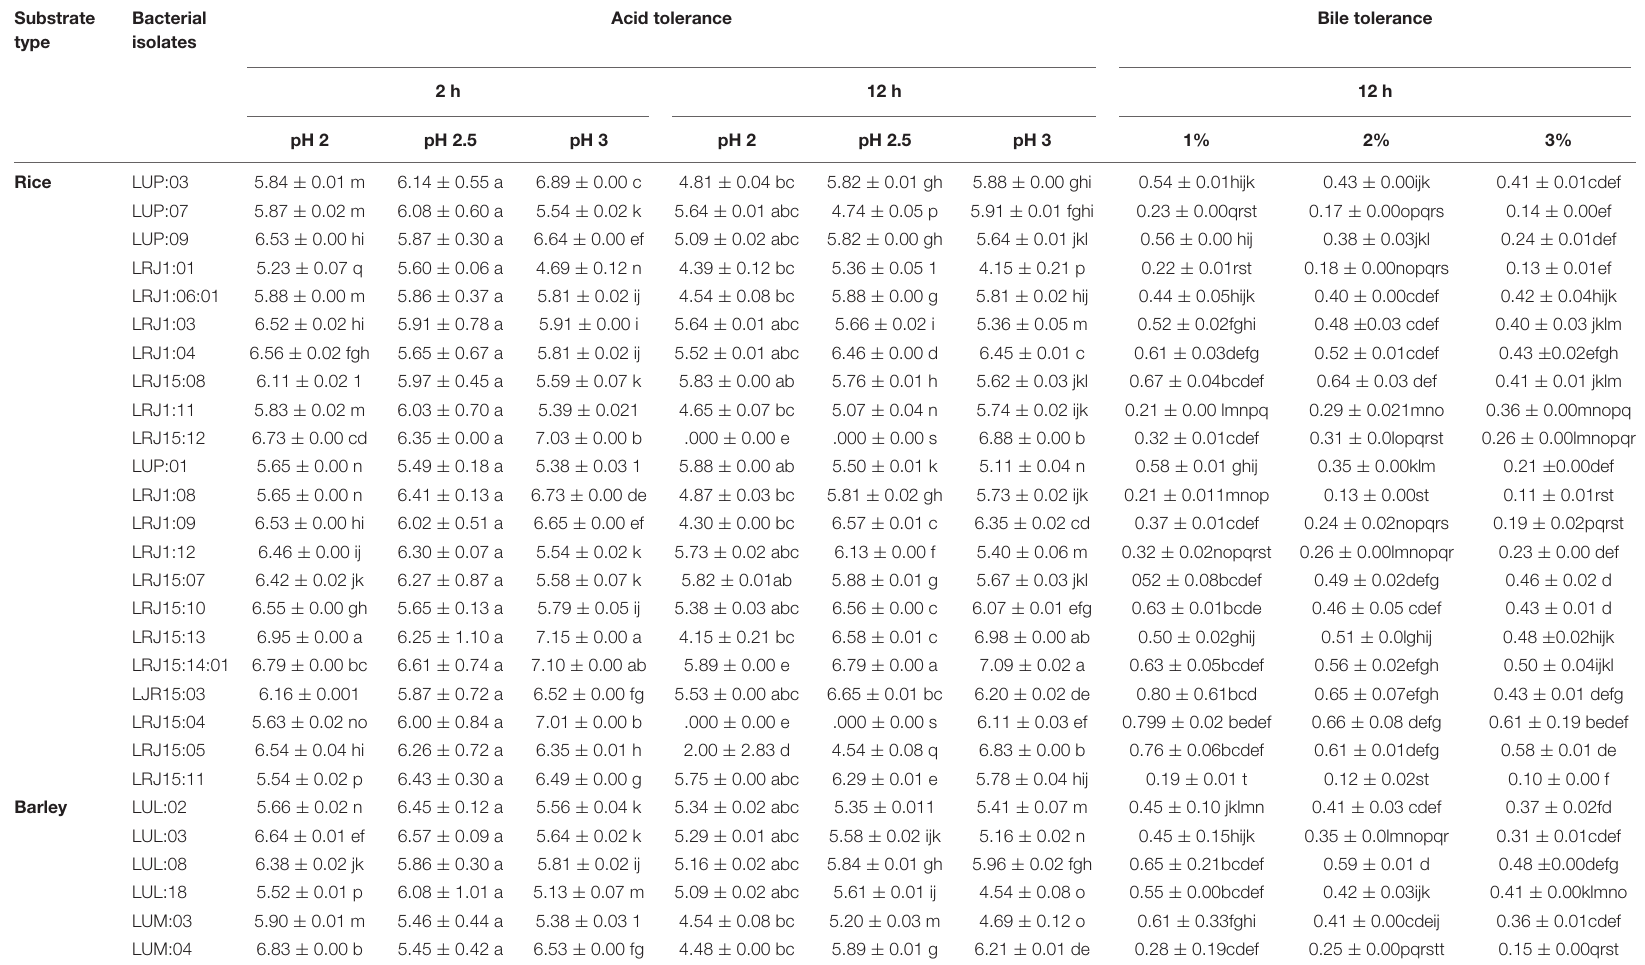
TABLE 3 | Survival of bacterial strains isolated from different undistilled substrate-based lugri (rice, barley, and wheat) under in vitro gastric phase containing pepsin and different bile concentration. Substrate Bacterial type